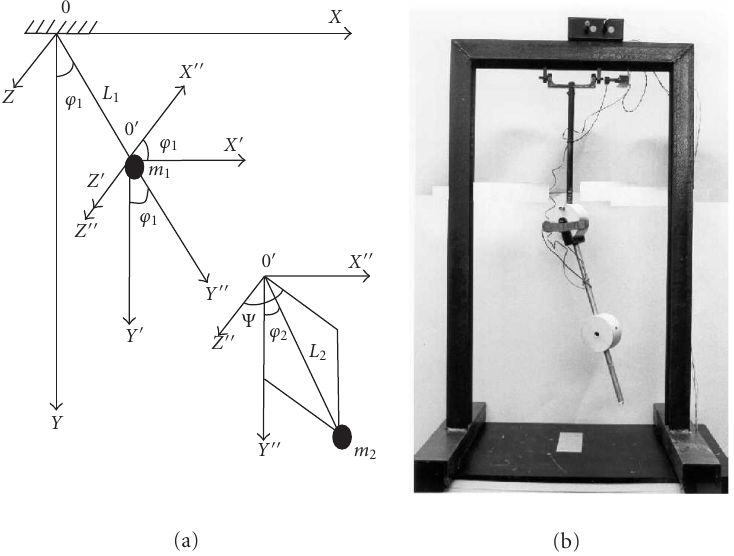
Figure 1.1. (a) Model and computation layout of an SDP; (b) photograph of the